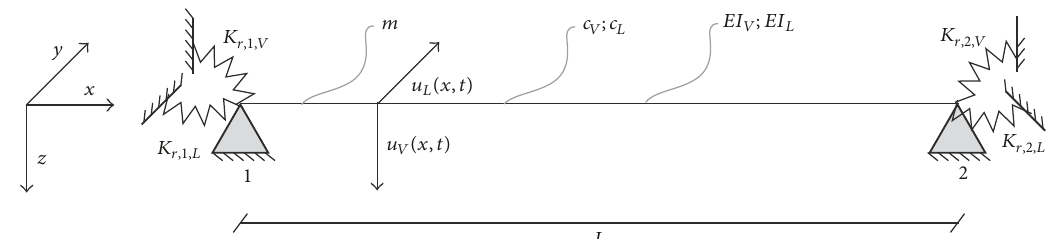
Figure 2: Beam characteristics: dynamic